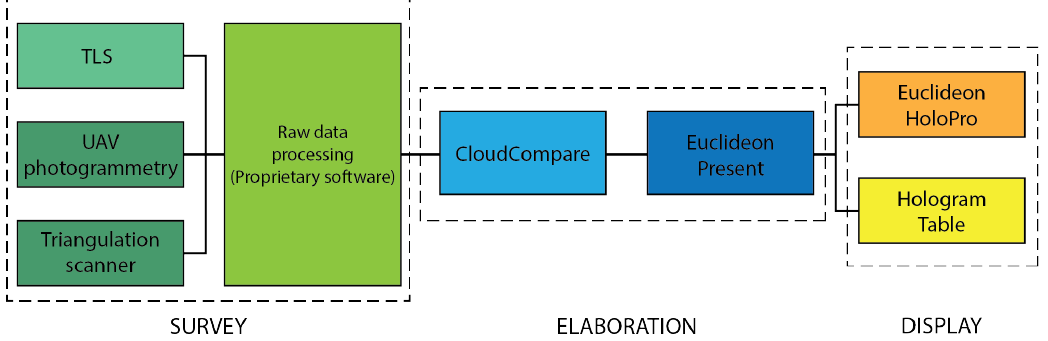
Figure 4. Workflow schema from survey to the holographic